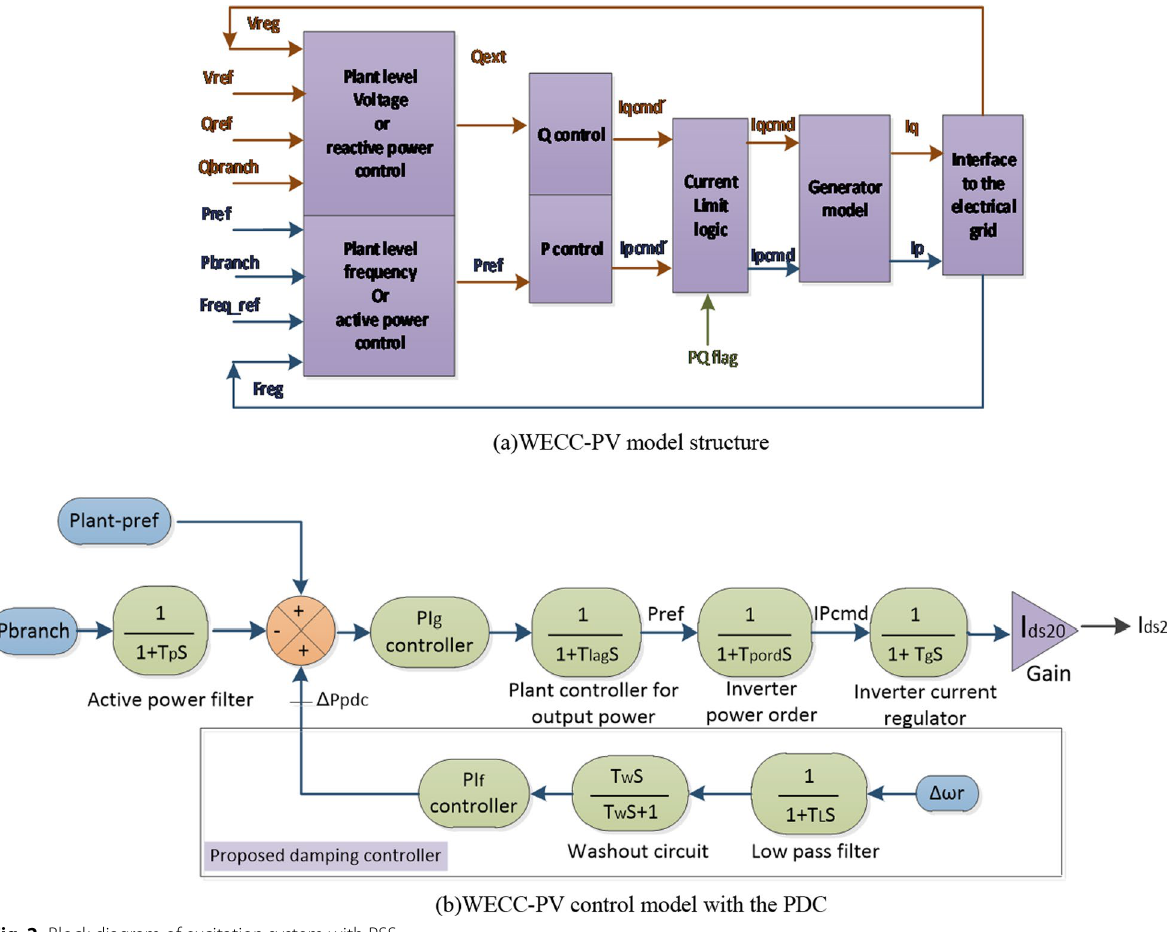
Fig. 2 Block diagram of excitation system with